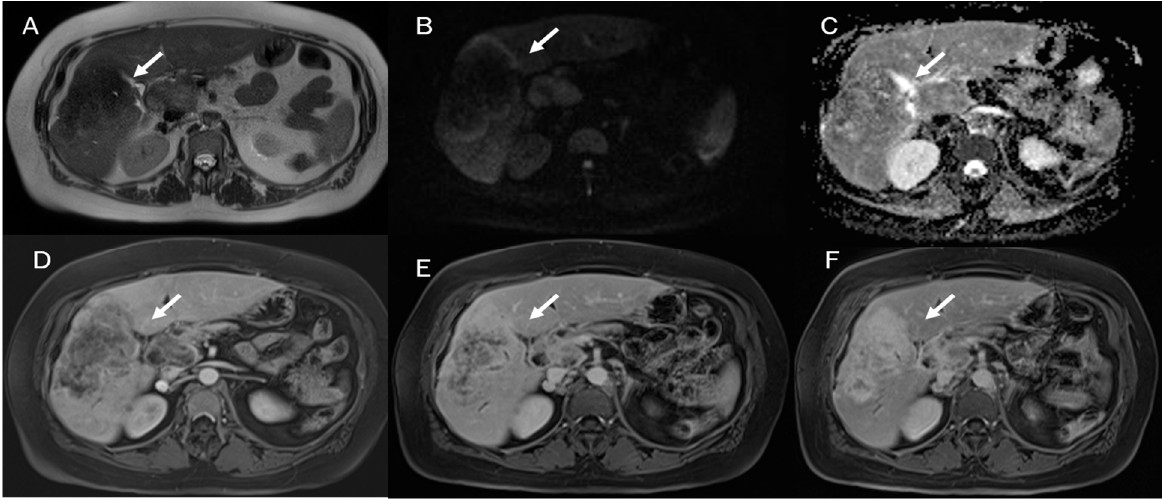
Figure 5. ICC MRI assessment. The lesion (arrow) shows hypointense signal in T2-W sequence ( A ) due to fibrotic tissue, with targetoid appearance in DWI ( B ) and ADC map ( C ) and progressive contrast enhancement during arterial ( D ), portal ( E ), and delay ( F ) phases of contrast study.